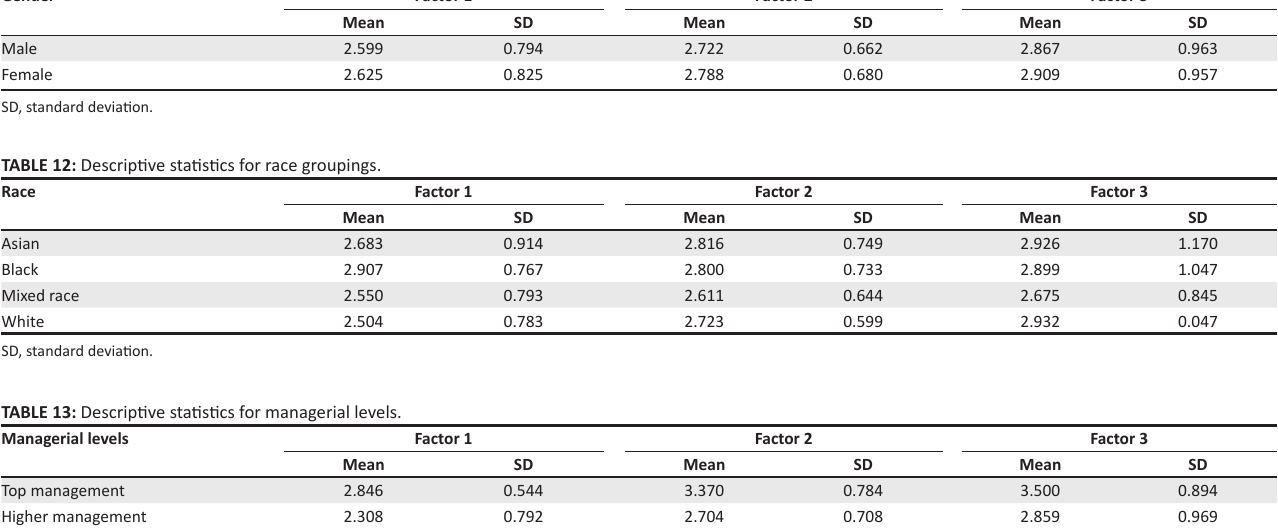
TABLE 11: Descriptive statistics for gender groupings. Gender